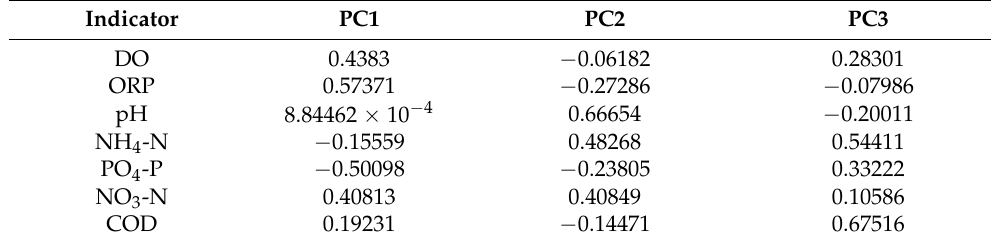
Table 2. Principal component (PC) of each